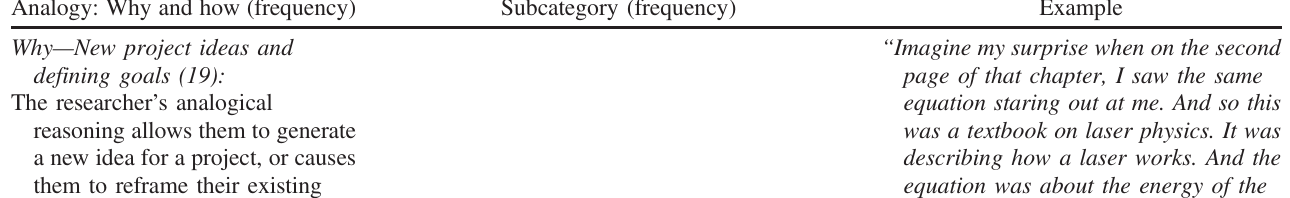
TABLE VII. Code descriptions and representative examples for analogies. Analogy: Why and how